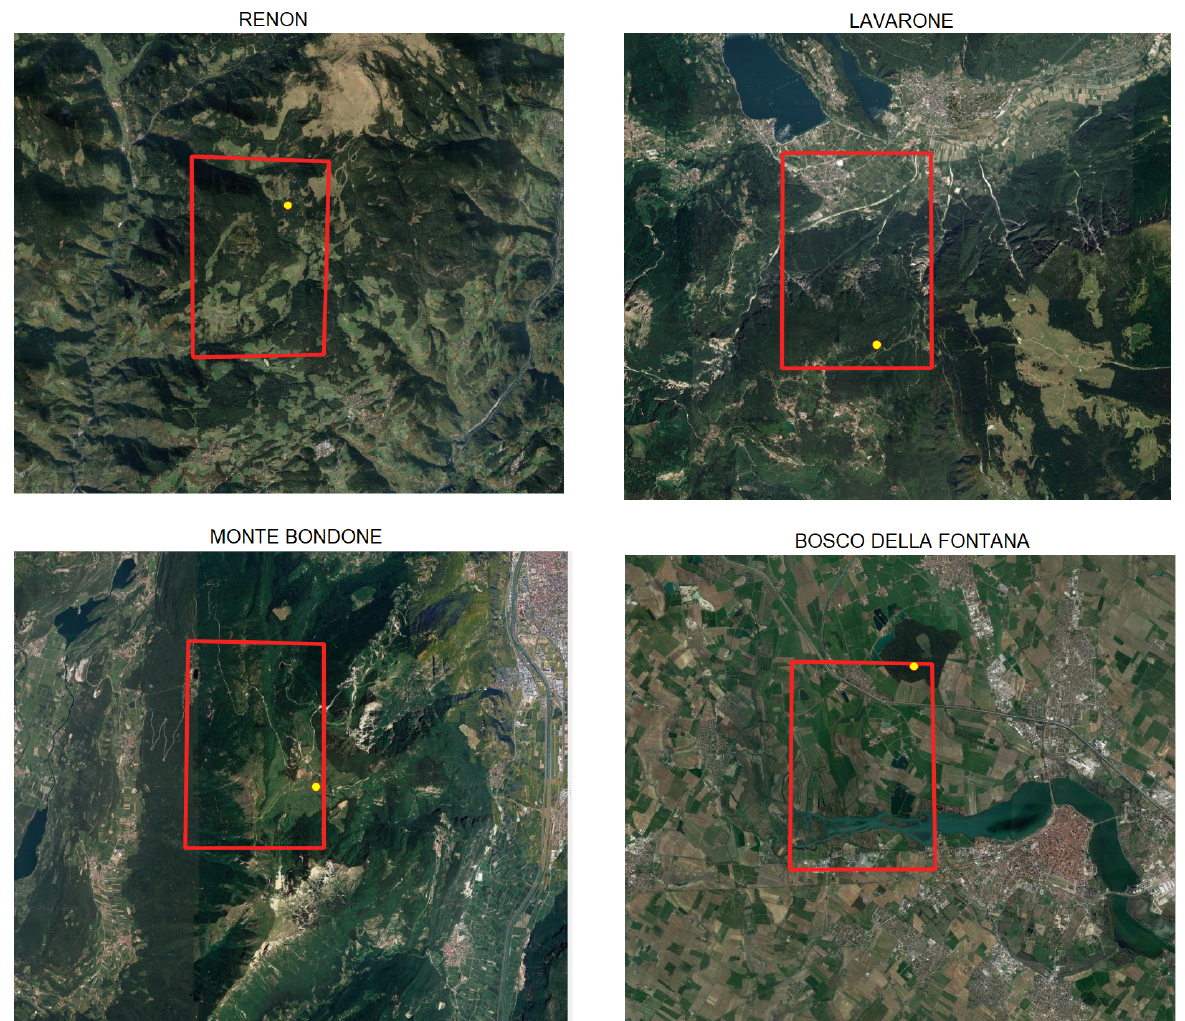
Figure 2. Google earth image with the location of the four eddy covariance towers (yellow points) for each site. In red, the CAMEL pixel used to derive the ECI. Date picture: Lavarone and Monte Bondone 6 December 2017; Renon 19 October 2017; Bosco delle Fontana 18 June